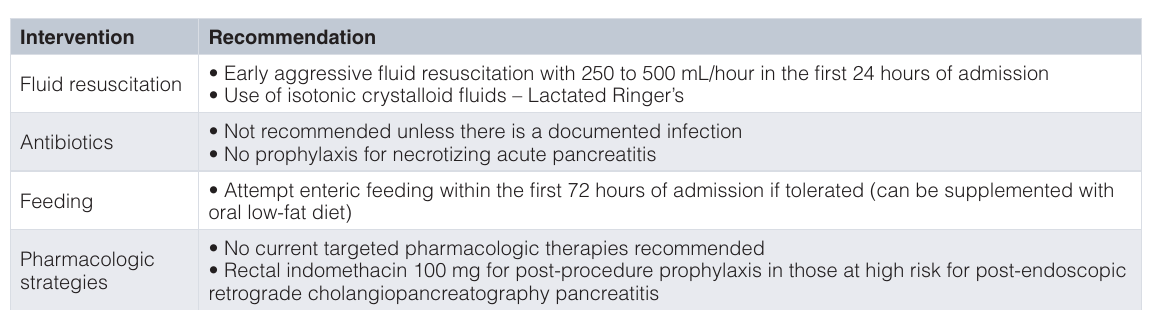
Table 1. Summary updates for the management of acute pancreatitis. Intervention Recommendation Fluid resuscitation